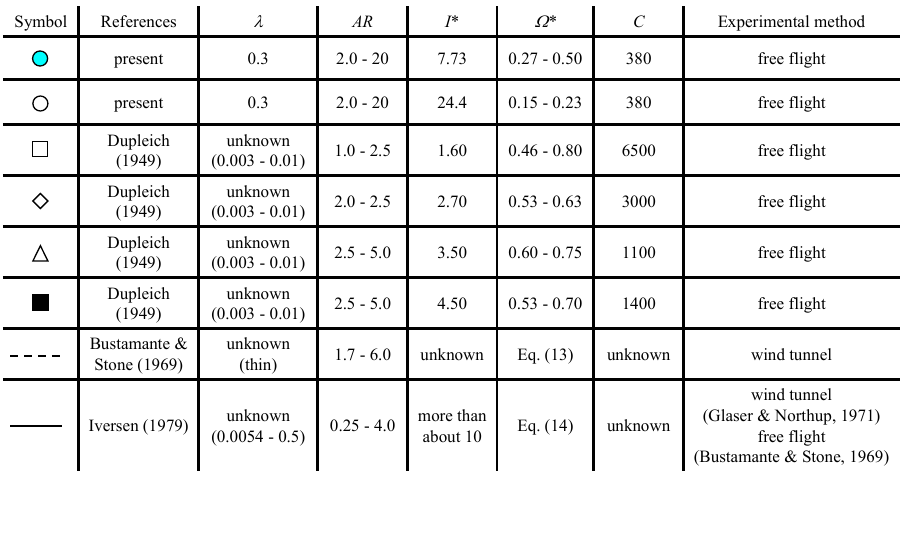
Table 1 Symbols and corresponding parameters, in Figs. 7 - 10.